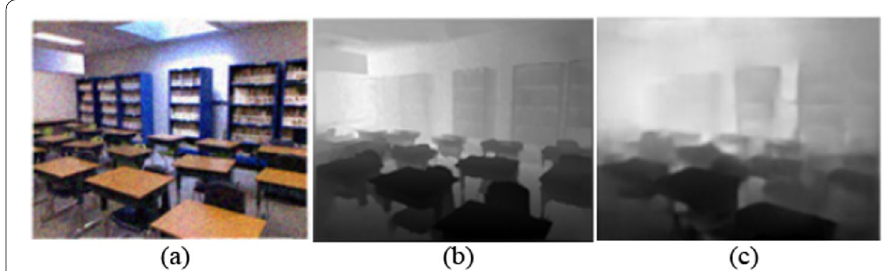
Fig. 1 The depth map with blurred edges achieved by depth estimation network [8]. a color image; b depth ground truth; c predicted depth